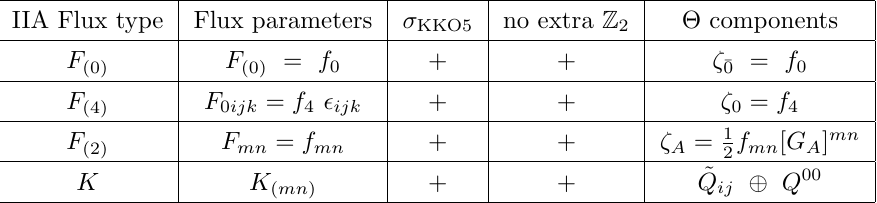
Table 9 . The explicit dictionary between type IIA (cid:13)uxes consistent with the KKO5 involution and deformation parameters of N = (1 ; 1) supergravity in six dimensions. The K mn tensor denotes the extrinsic curvature of the 4-sphere as explained in